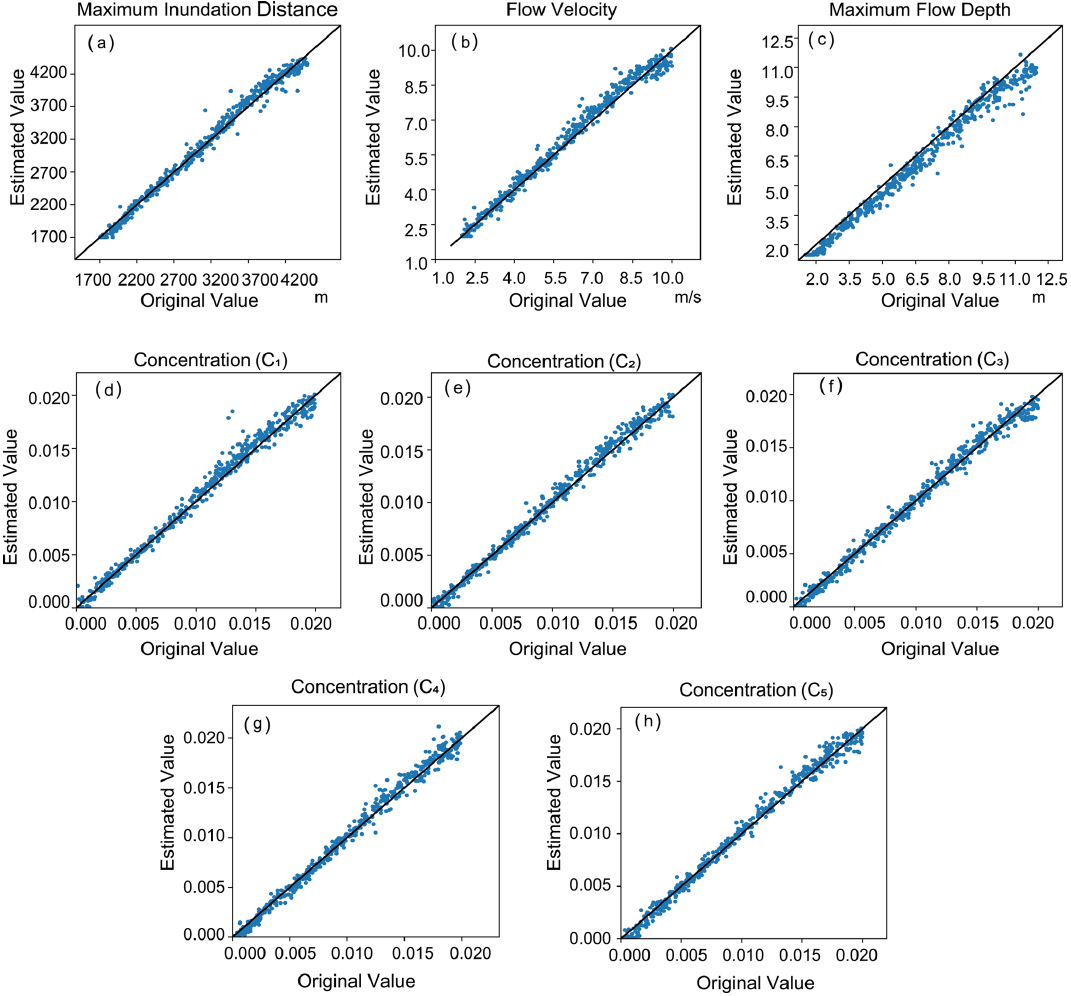
Figure 7. Performance verification of the model using artificial test data sets, indicating that the values estimated using the inverse model were plotted against the original values used for the production of the test data sets. Solid lines indicate a 1 : 1 relation and suggest good